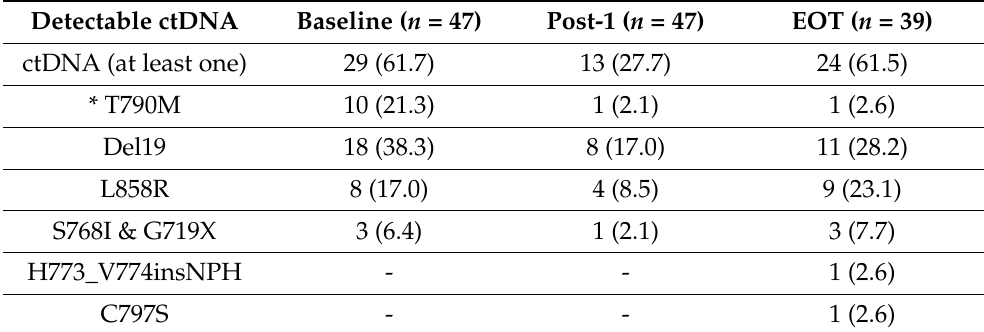
Table 3. Detection of ctDNA at each time